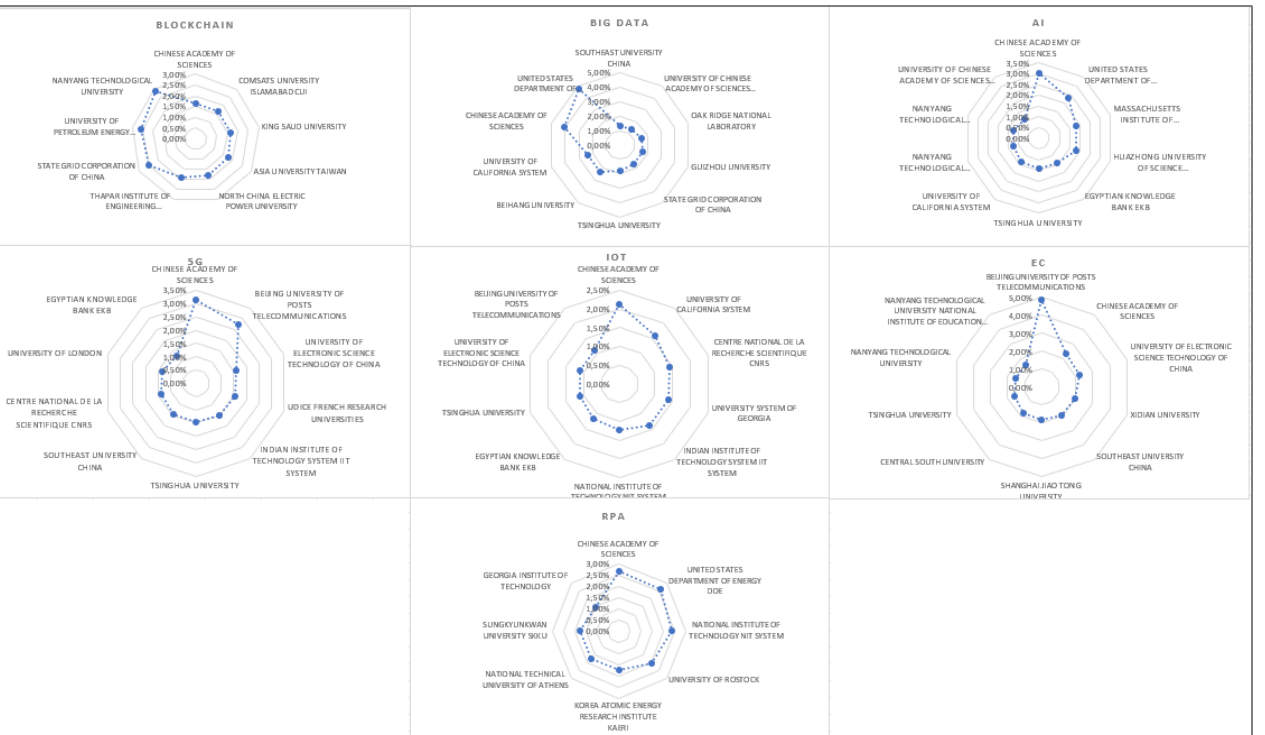
(Figure 7): Zhang Y—the leading position in AI with 133 of papers, 5G with 87 of papers, IoT with 138 of papers, and edge computing with 67 of papers; Wang J—the leading position in big data with 115 of papers; Kumar N—the leading position in blockchain with 51 of